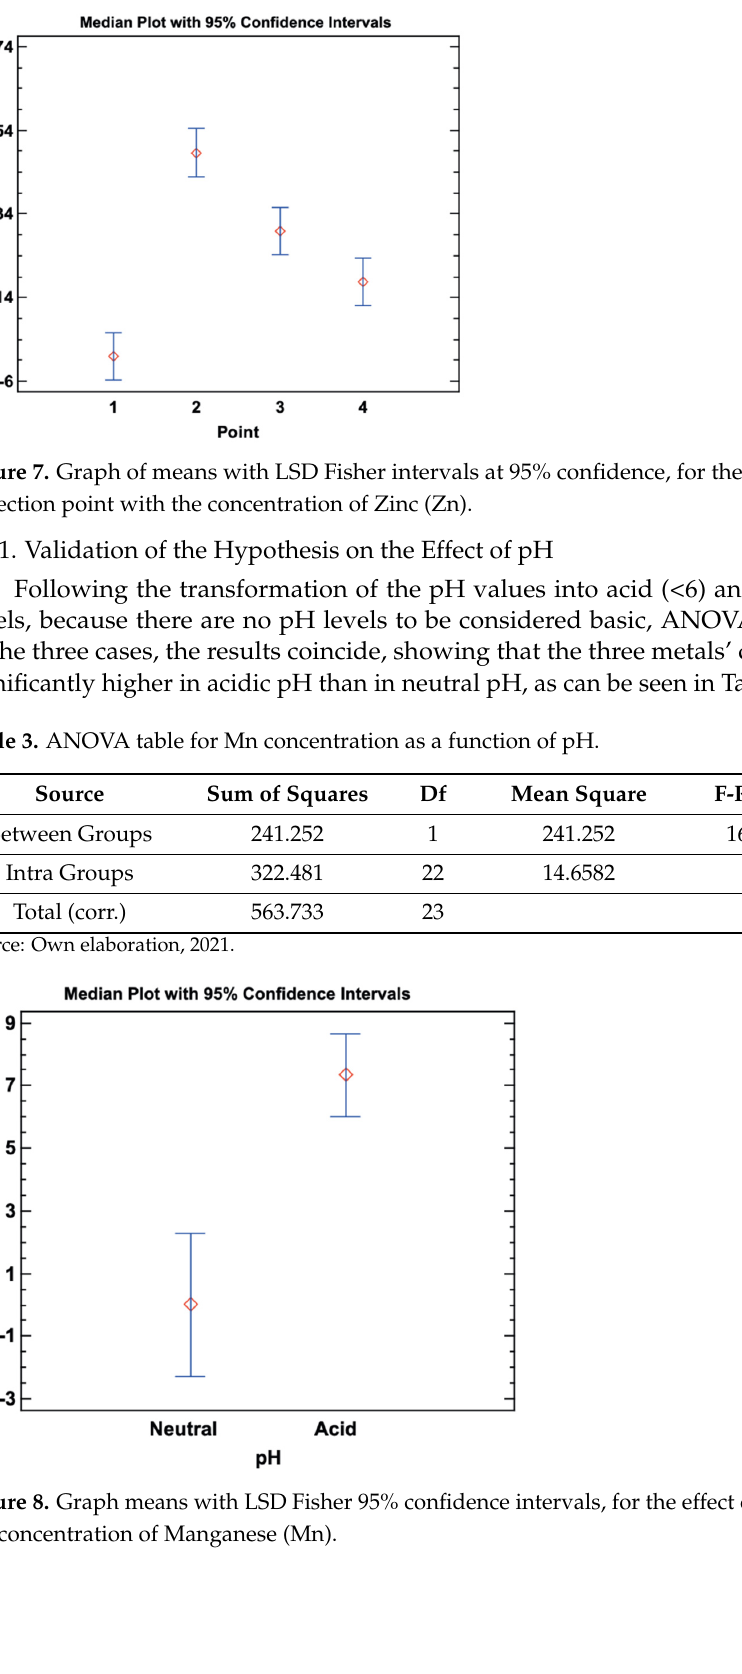
Table 2. ANOVA table for Zn concentration as a function of collection point 2.